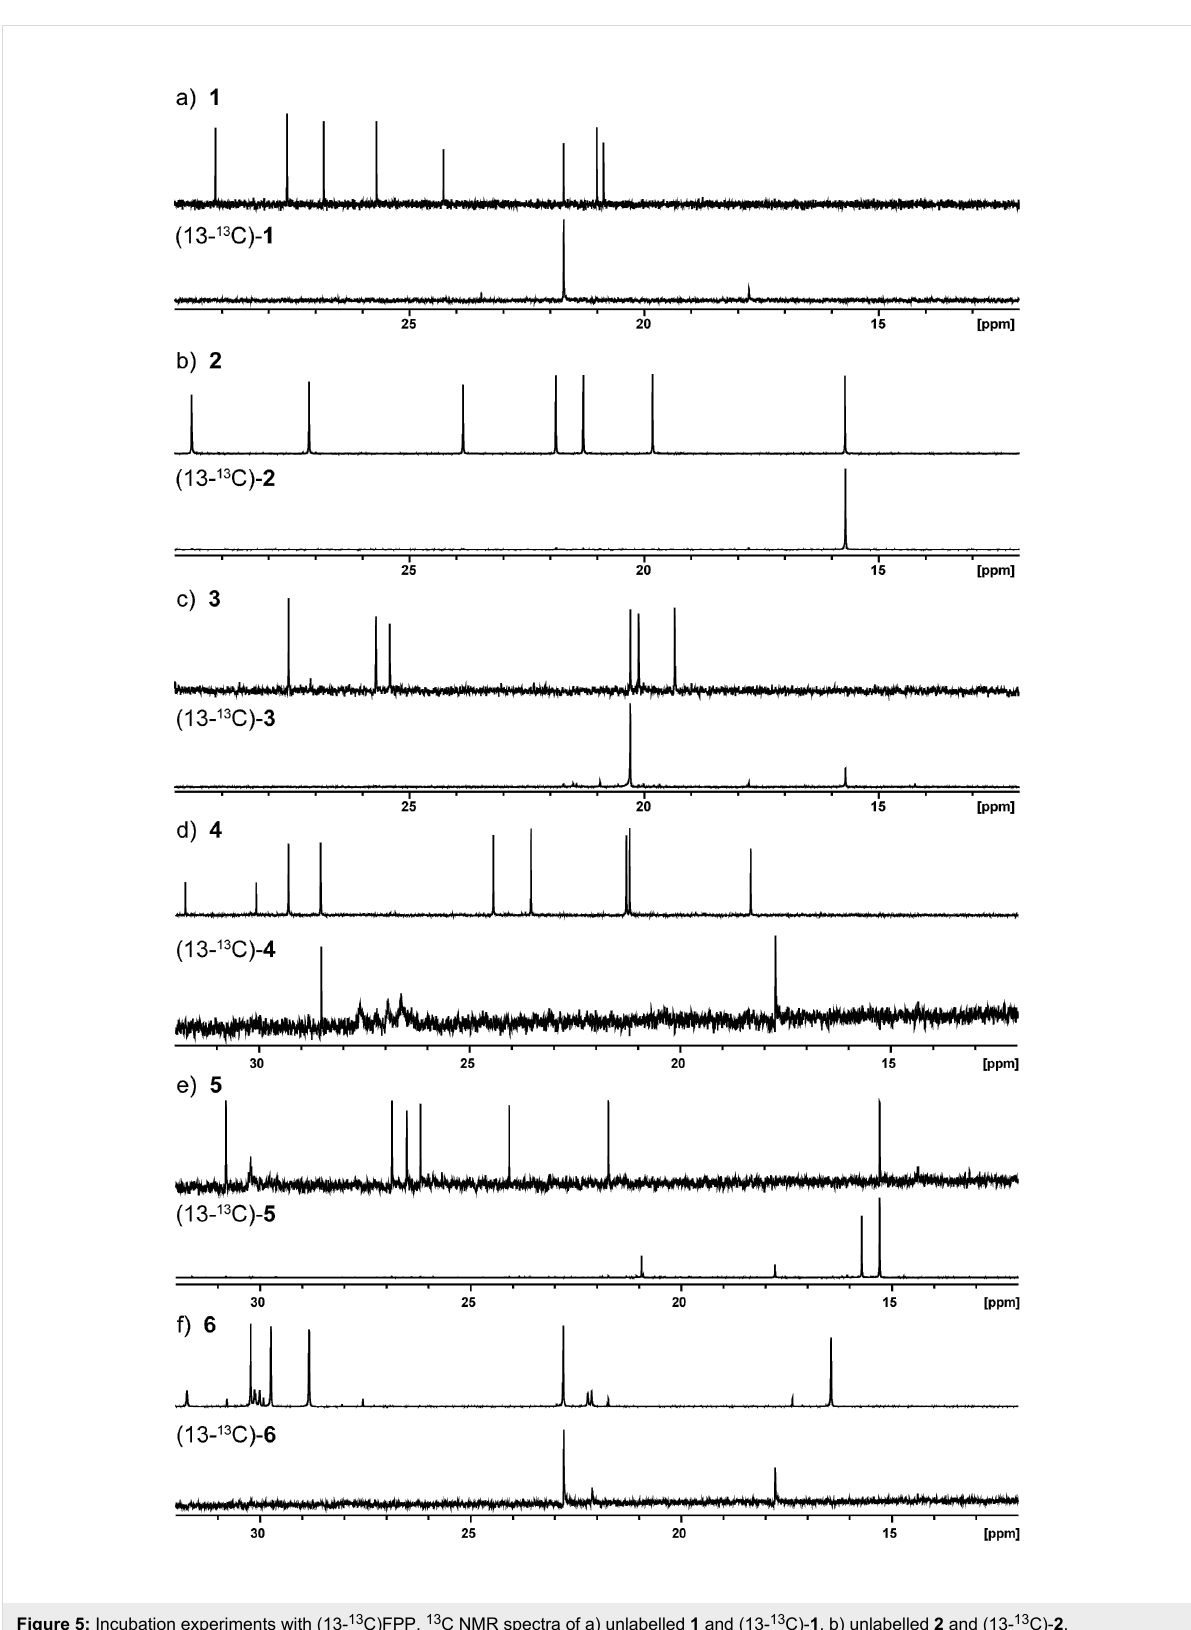
Figure 5: Incubation experiments with (13- 13 C)FPP. 13 C NMR spectra of a) unlabelled 1 and (13- 13 C)- 1 , b) unlabelled 2 and (13- 13 C)- 2 , c) unlabelled 3 and (13- 13 C)- 3 , d) unlabelled 4 and (13- 13 C)- 4 , e) unlabelled 5 and (13- 13 C)- 5 , f) unlabelled 6 and (13- 13 C)- 6